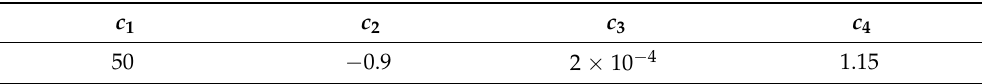
Table 2. Material constants for the CDM model based on accumulated inelastic hysteresis